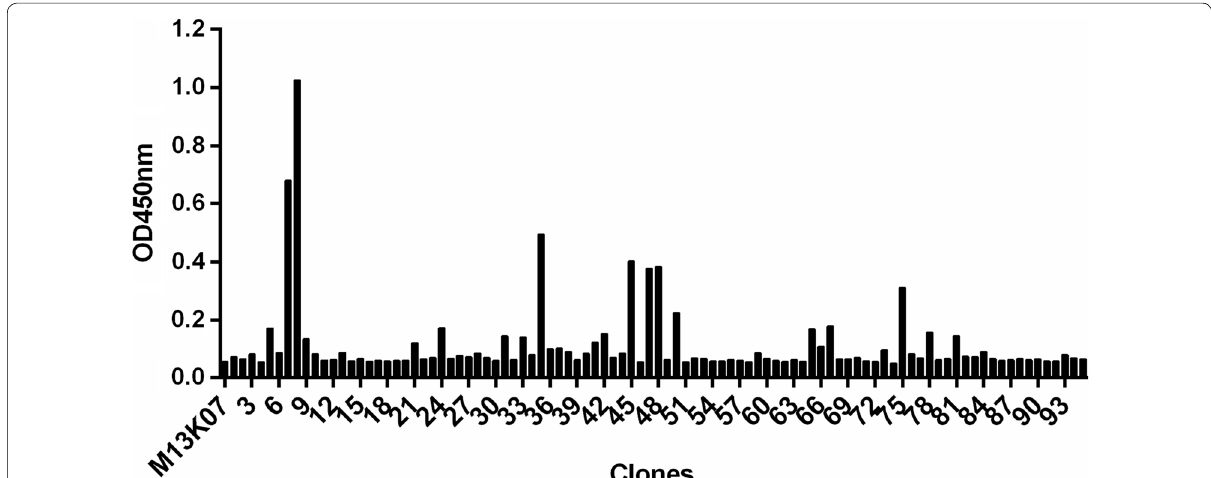
Fig. 3 The PEDV spike protein-specific recombinant phages were identified by phage ELISA. The recombinant phages of 96 clones that were randomly picked from the third round of panning were added to microplates coated with the PEDV spike protein, and the bound phages were